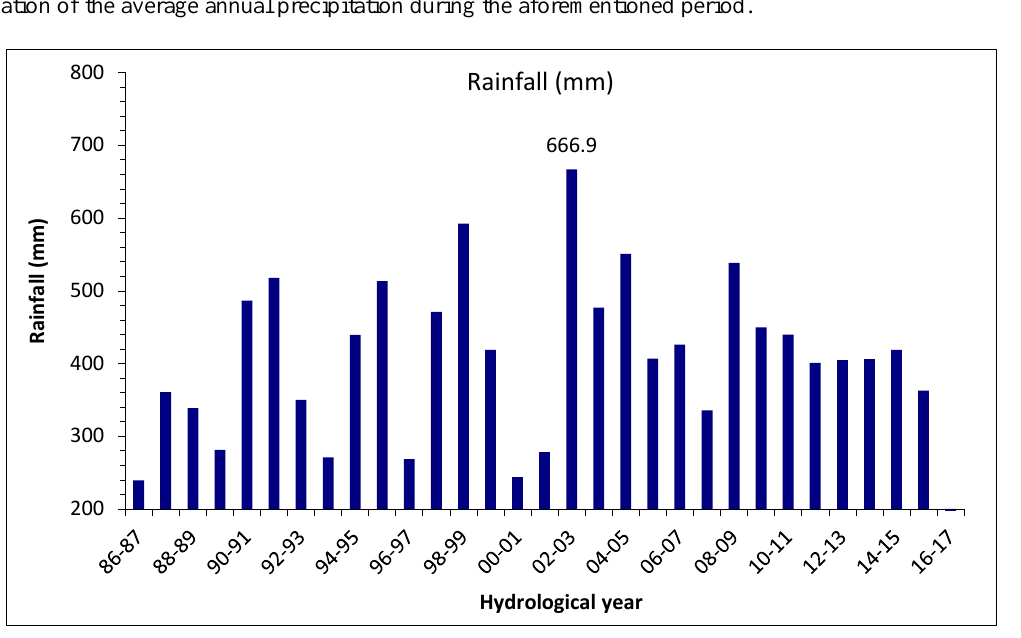
Figure 26. Variation in average annual precipitation during the period from 1987/1988 to 206/2017 at rainfall station of Hammam-Grouz